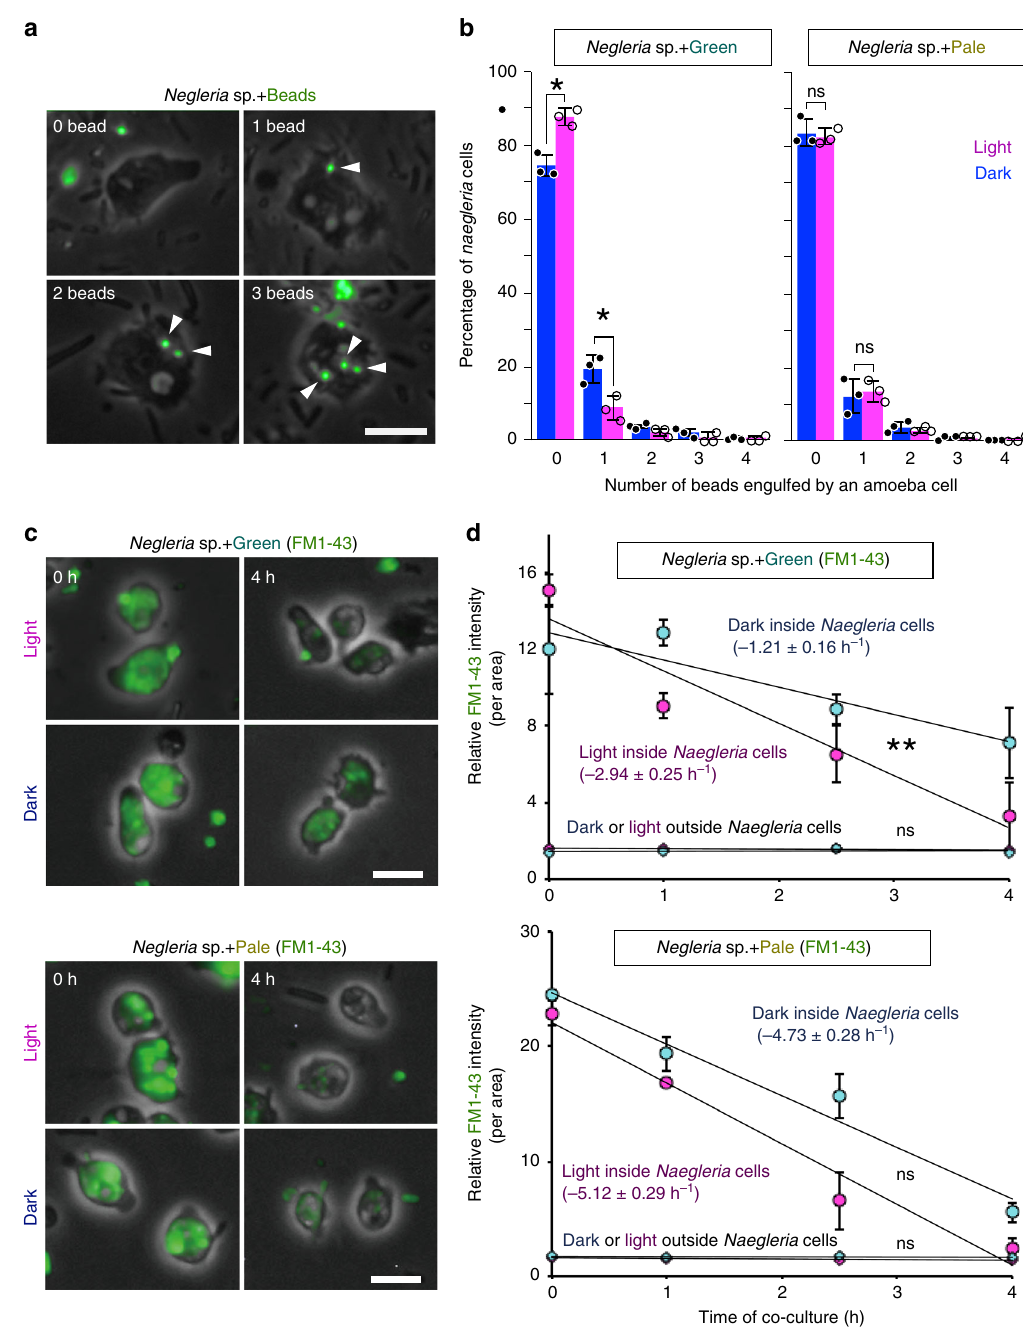
Fig. 5 Effect of the photosynthetic trait of bacterial prey on ingestion and digestion of prey by Naegleria sp. a , b Naegleria sp. was co-cultured with green or pale S . elongatus prey under dark conditions and then either kept in the dark or illuminated (200 μ E m − 2 s − 1 ; light) for 1 h. After that, the culture was incubated under dark or light conditions with green fl uorescent beads (1 µ m in diameter) for 1 h. a Micrographs of Naegleria sp. cells that ingested 0 – 3 beads (green). Scale bar = 10 µ m. b Number of fl uorescent beads ingested by Naegleria sp. cells in respective co-cultures. The error bar represents s.d. of three independent cultures (cultured at the same time). * p < 0.05; ns, not statistically signi fi cant ( t -test). Source data are provided as a Source Data fi le. c , d Naegleria sp. was co-cultured with green or pale prey (cell membrane was stained with the green fl uorescent FM1 – 43) in the dark and then immobilized on MAS-coated glass so as not to newly ingest bacterial prey. Then (hour 0), the cells were kept under dark or illuminated (200 μ E m − 2 s − 1 ) for 4 h. c Naegleria sp. cells (phase-contrast microscopy) digesting green or pale S . elongatus prey stained with green FM1 – 43 (green fl uorescence) under dark or light conditions. Scale bar = 10 µ m. d Decrease in FM1 – 43 fl uorescence inside Naegleria sp. cells in respective conditions. Change in the fl uorescence of free prey outside Naegleria sp. cells was also determined as a control. The error bar represents s.d. of three independent cultures (cultured at the same time). * p < 0.05; ** p < 0.005; ns, not statistically signi fi cant ( t -test; inclination in the light vs. that in the dark). Source data are provided as a Source Data fi